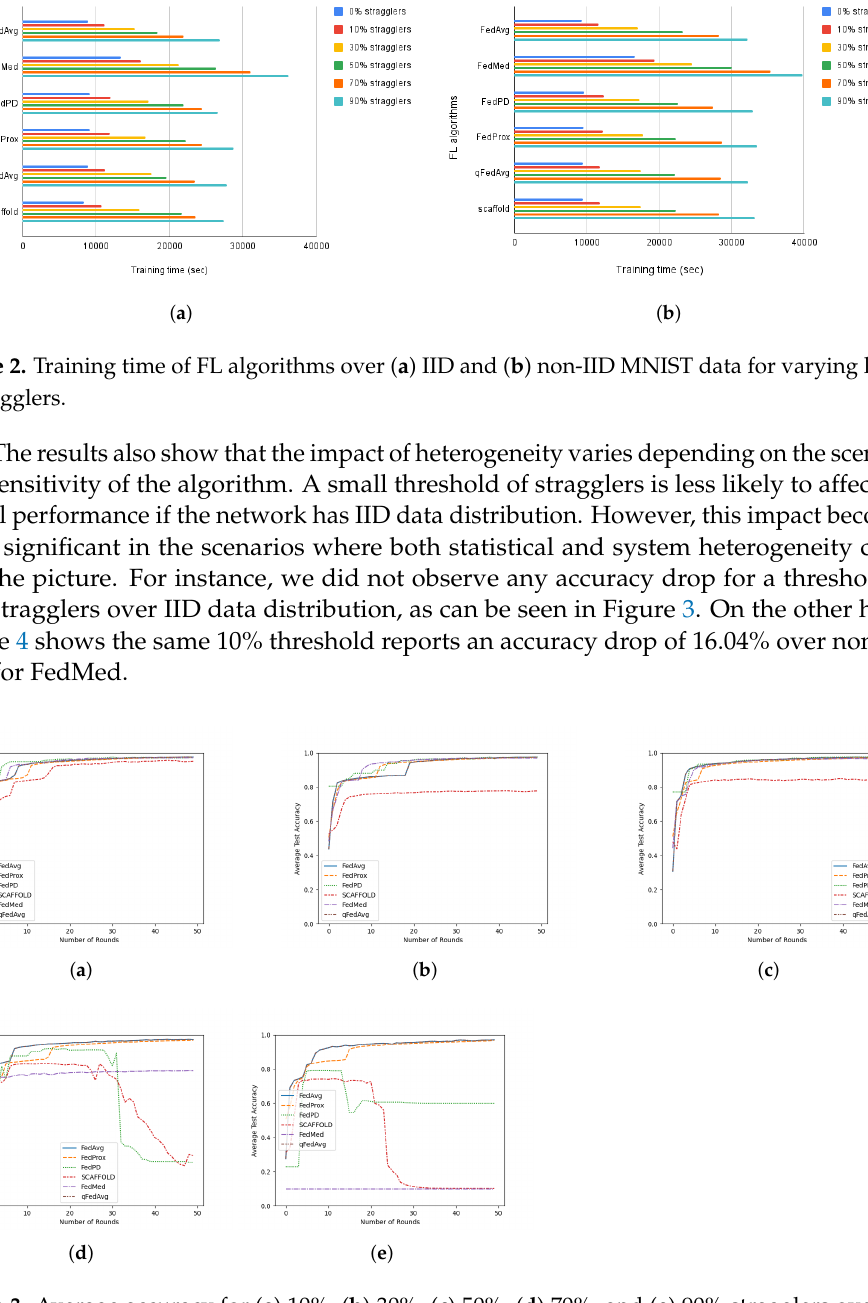
Figure 3. Average accuracy for ( a ) 10%, ( b ) 30%, ( c ) 50%, ( d ) 70%, and ( e ) 90% stragglers over IID data for MNIST data